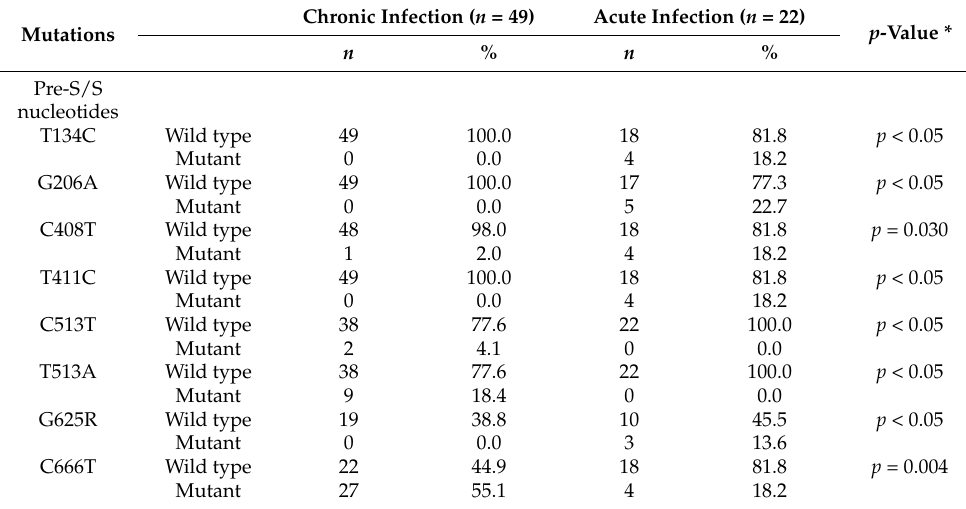
Table 2. Analysis of nucleotide mutations in the pre-S/S region.